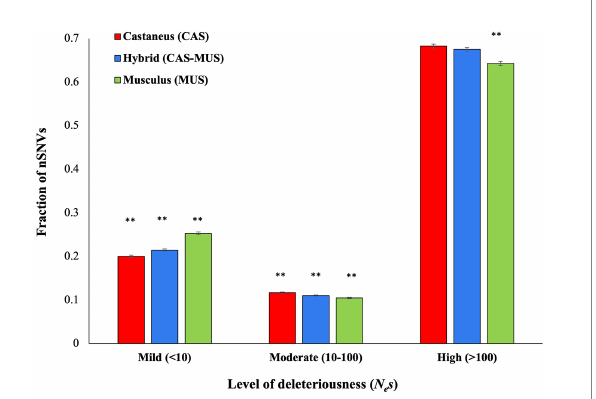
FIGURE 6 Distribution of fitness effects of nonsynonymous SNVs (nSNVs). The X-axis shows the level of deleteriousness of nSNVs in terms of the product of effective population size ( N e ) and selection coefficient ( s ). The nSNVs were grouped into mildly ( N e s < 10), moderately ( N e s 10– 100) and highly ( N e s > 100) deleterious in nature. The double asterisks indicate statistical significance at the 1% level ( Z -test, two-tailed). The actual p -values for each comparison are given in the main text (see